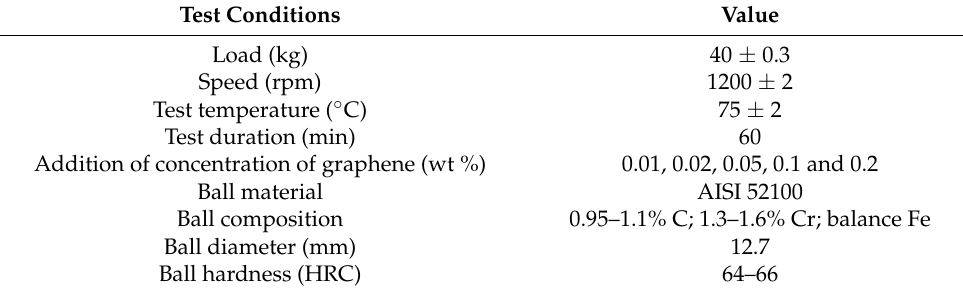
Figure 2. Schematic representation of four-ball tester. Table 4. Test conditions of the four-ball tribology experiments.